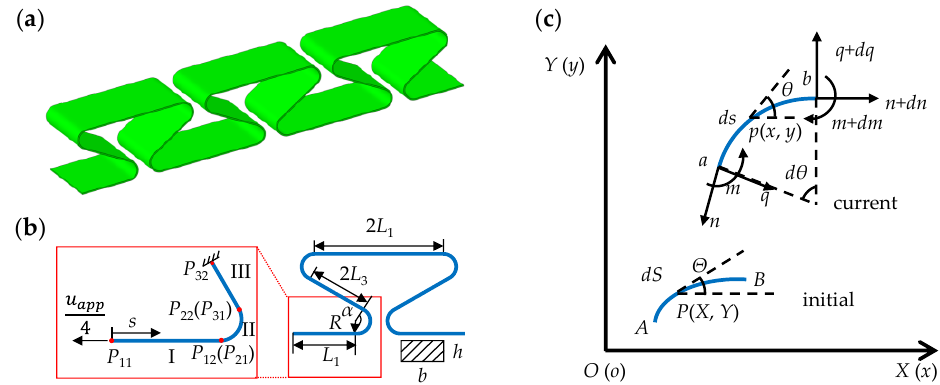
Figure 1. The diagram of horseshoe-shaped structure. ( a ) The three-dimensional view of horseshoe- shaped structure with three periods; ( b ) the simplified mechanical model; ( c ) the infinitesimal arc sections before and after deformation.